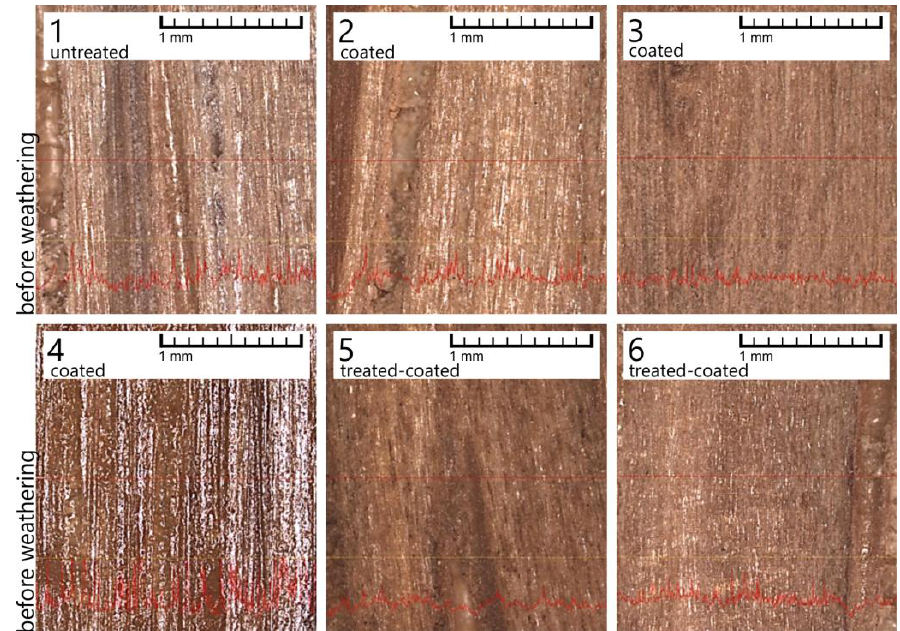
Figure 3. Samples before artificial weathering (0 weeks); reference untreated oak ( 1 ); oak treated with hydrophobic coating A ( 2 ); oak treated with hydrophobic coating B ( 3 ); oak treated with oil based coating C ( 4 ); oak with surface modification No. 3 and hydrophobic coating A ( 5 ); oak with surface modification No. 4 and hydrophobic coating B ( 6 ).